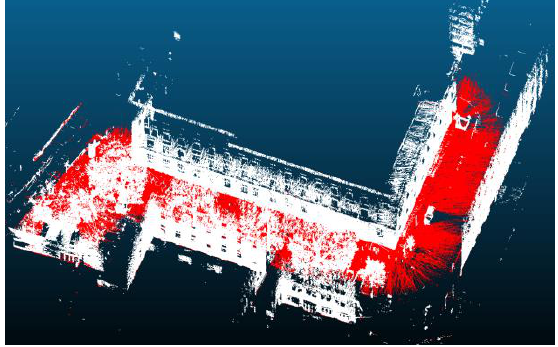
Figure 3. captured point cloud from Zeb1